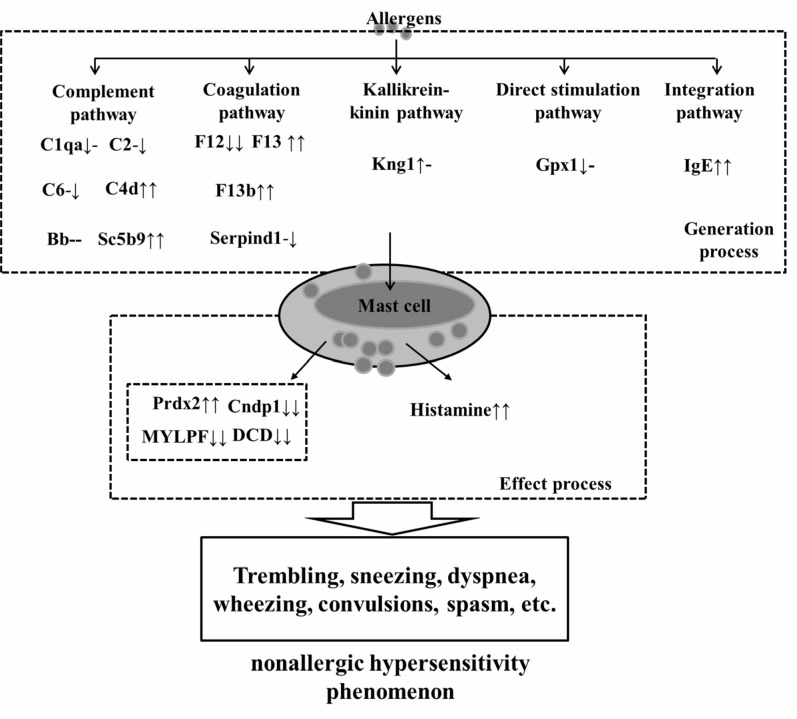
A proposed generation and effect mechanism study of nonallergic hypersensitivity reaction according to KEGG nomenclature through proteomics.The levels of potential biomarkers were labeled with “↑” up-regulated, “↓” down-regulated and “-” no significant difference comparing with control group, the left was C4880 group and the right was OVA group.